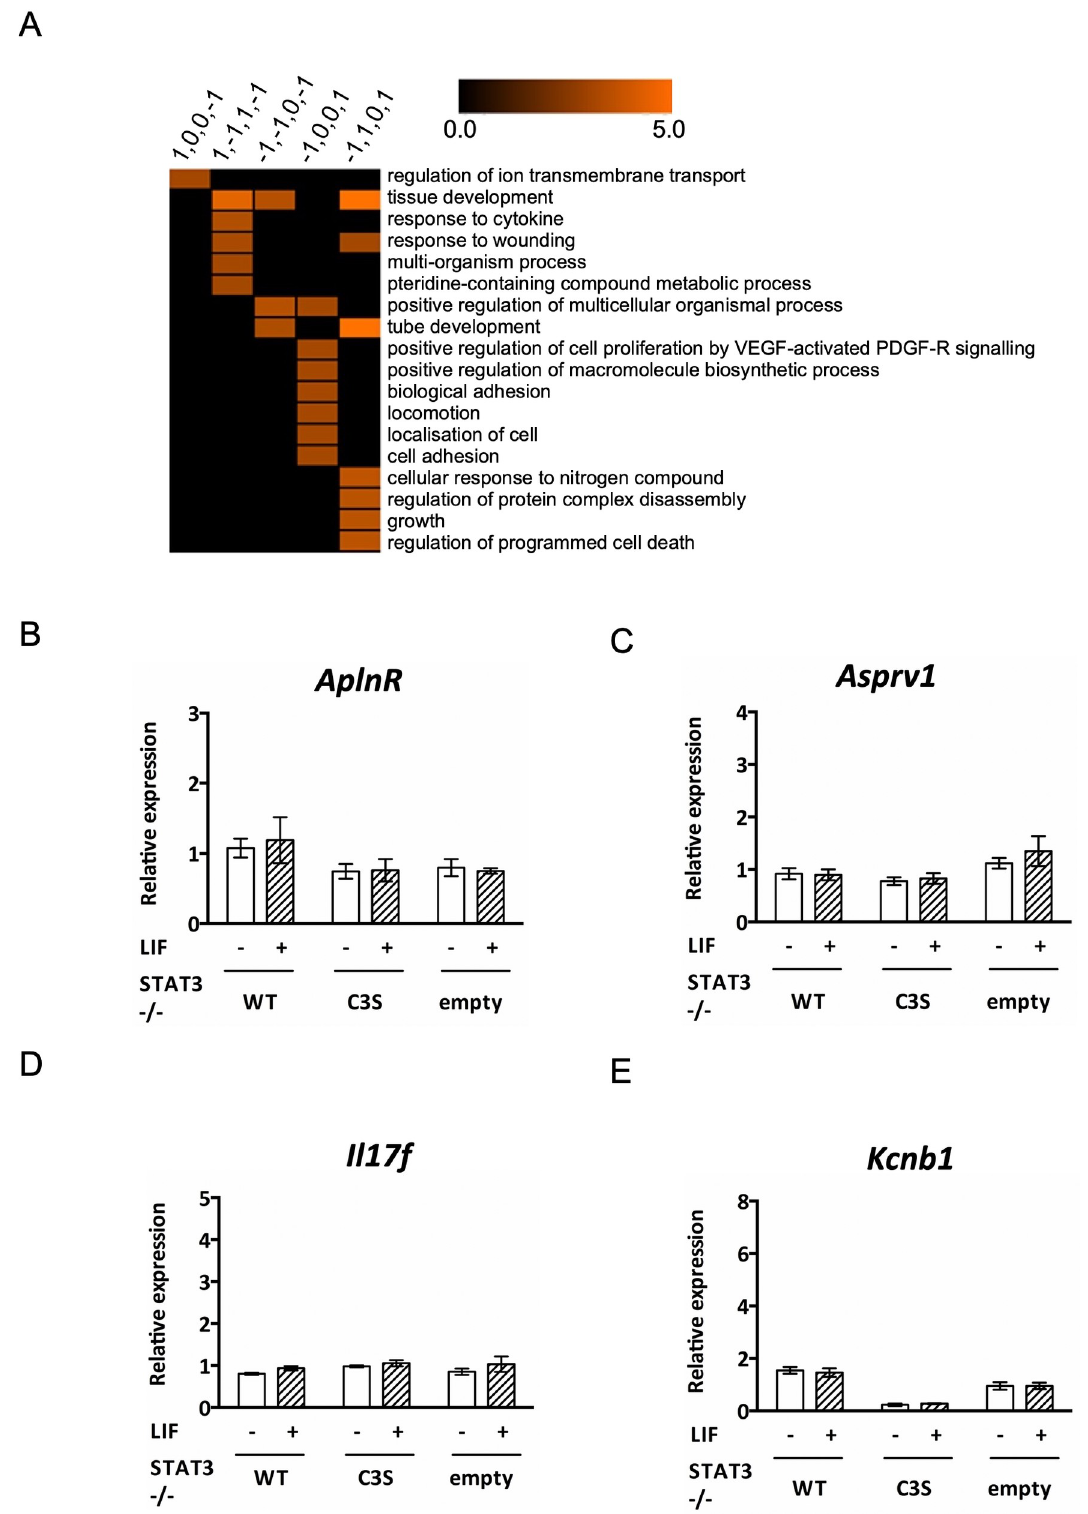
Fig 3. GO enrichment of clusters that showed Stat3 oxidation-responsive gene expression. A) Pruned version of total GO enrichment for 5 (out of 10) expression clusters displayed in Fig 2D (the remaining five clusters do not show enrichment for any